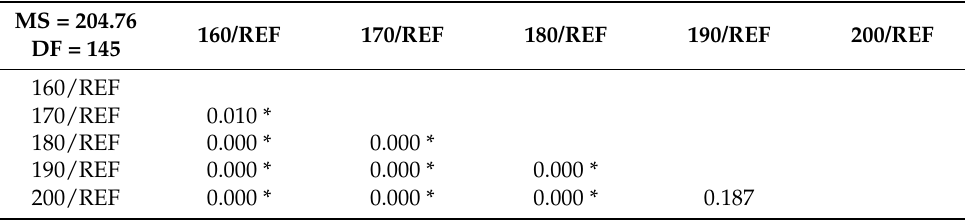
Table A11. Duncan ´ s multiple range test for changes in degree of gloss at 20 ◦ .